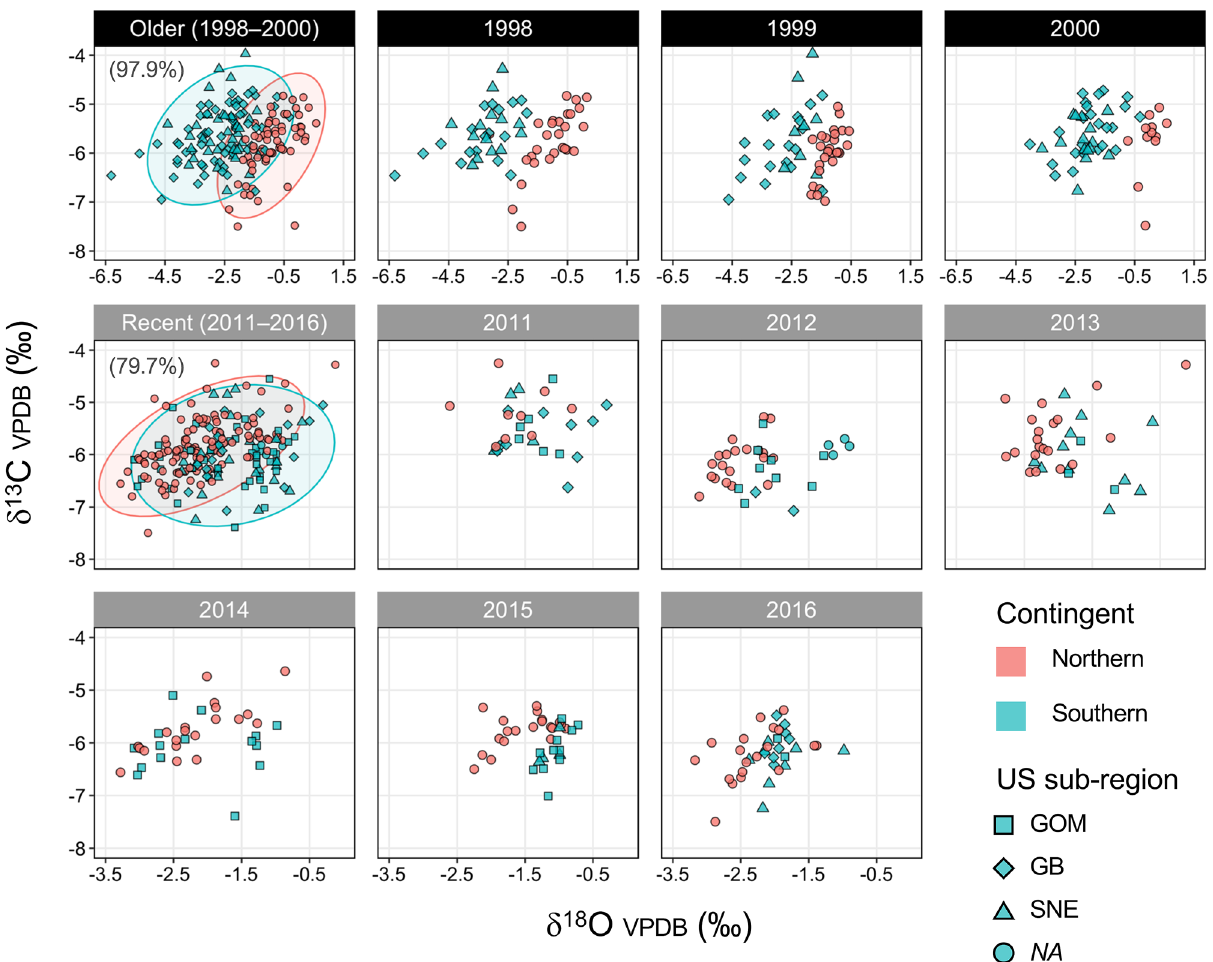
Figure 3. Otolith oxygen and carbon stable isotopes (δ 18 O/δ 13 C values) for Northwest Atlantic mackerel juvenile baseline samples collected in Canadian and US waters for older (black headers: 1998–2000) and recent (gray headers: 2011–2016) year-classes. The left plots in the first and second rows provide values for all year-classes combined with 95% confidence ellipses and cross-validated classification accuracy with threshold probability level of > 0.7 shown. Different symbols within US juvenile samples represent samples collected at different regions within US waters with NA indicating samples with no information on location of capture. All isotope values were reported in delta notation with respect to Vienna-Pee Dee Belemnite (V-PDB). Age-2 samples collected in the summer Canadian fishery in the Gulf of St. Lawrence were included in baselines for year-classes 1998, 1999, 2011, and 2016 to complement age-1 northern contingents that were insufficient in samples size. Note that the scales of the x-axis differ between older and recent samples. Data for year-classes 1998–2000 and 2011 are from Redding et al . 18 .